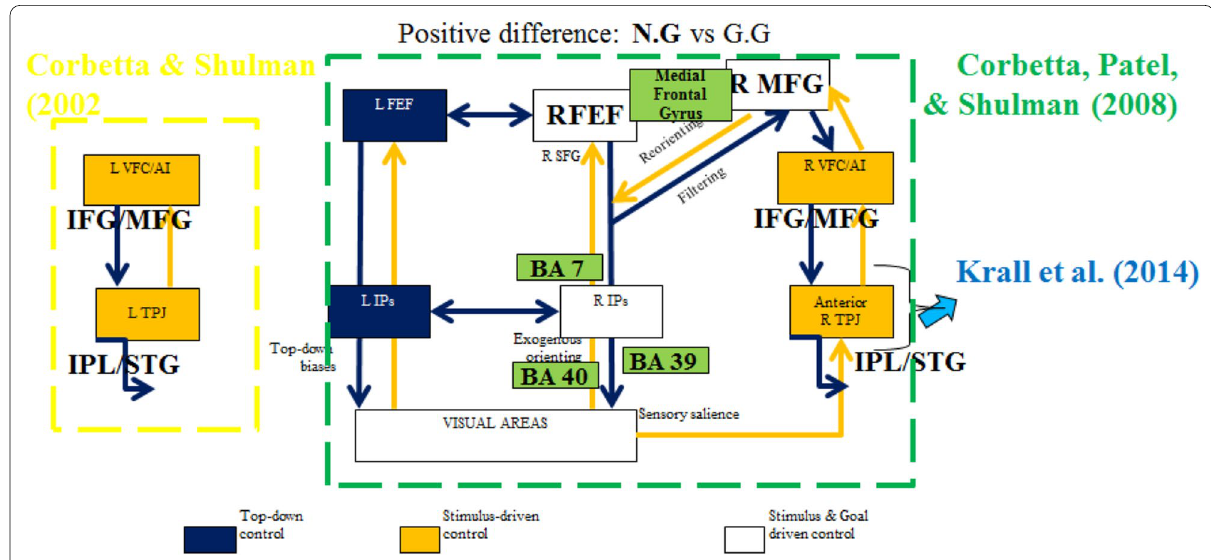
Fig. 5 Positive differences of the brain regions for the contrast N.G vs. G.G, showing an interaction between Filtering and Reorienting mode of attention. Several attention areas on the Right hemisphere were with relatively greater activations to the NG